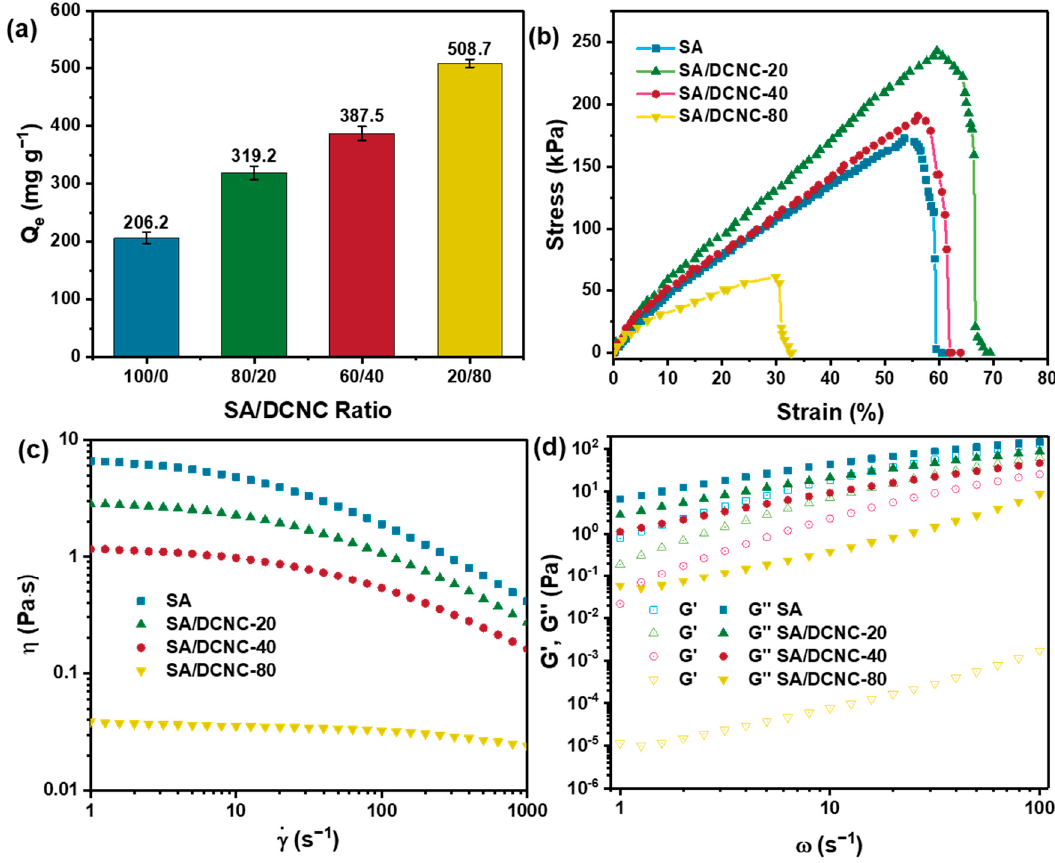
Figure 6. ( a ) Effect of SA–DNCN weight ratio on doxycycline adsorption efficiency ( C 0 = 500 mg L − 1 , pH = 7, 24 h); ( b ) tensile stress–strain curves of hydrogel strip samples with different SA–DCNC composition ratios; ( c ) shear rate dependence of viscosity, and ( d ) angular frequency dependence of storage modulus (G ′ ) and loss modulus (G ″ ) for 2.5 wt.% of various SA–DCNC mixture suspensions.